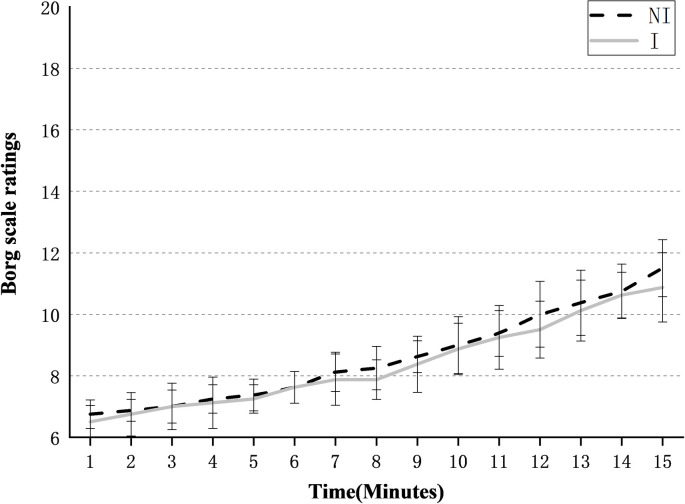
Mean Borg scale ratings of 8 subjects over time for the IPAE(I) and No-IPAE(NI) conditions.